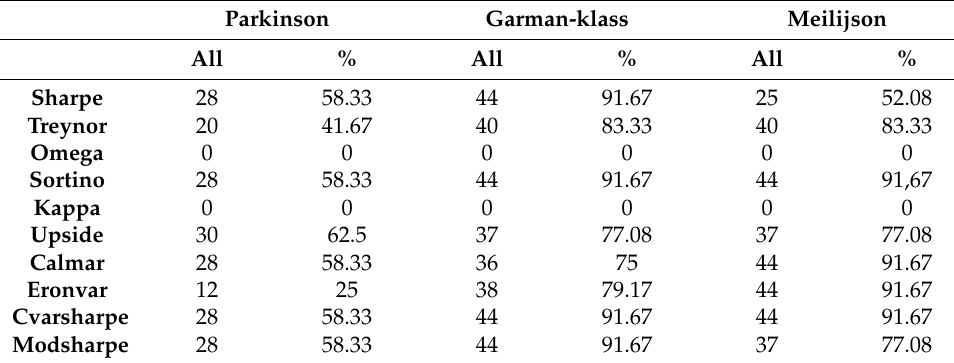
Table 7. Outperformance summary using standardized